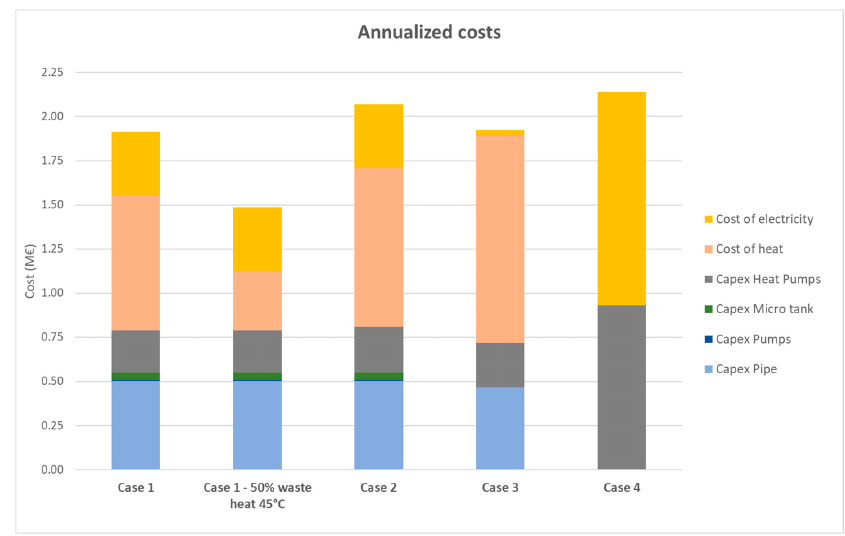
Figure 10. Annualized cost comparison of simulated cases (Case 1 assumed 50% recovery of waste heat).